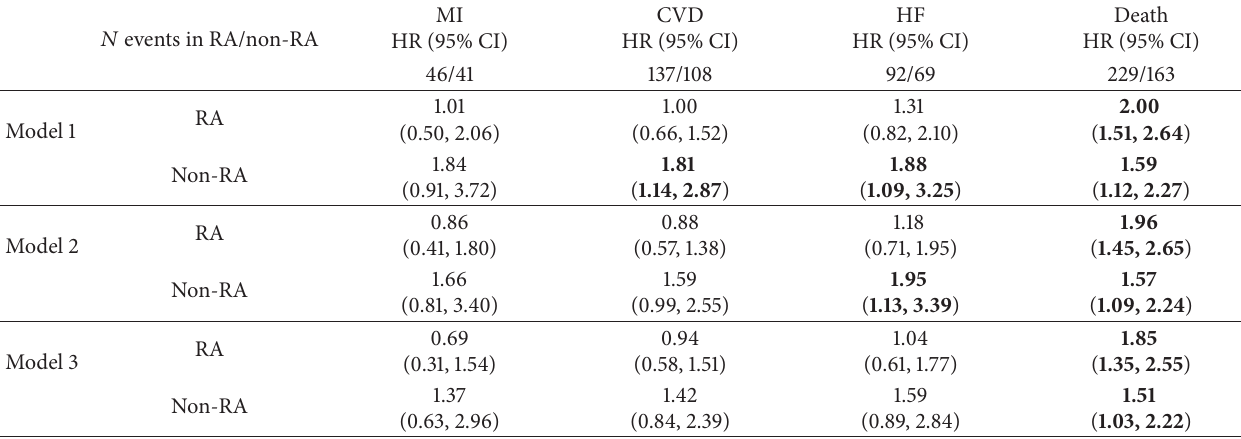
Table 3: Associations between hyperuricemia and cardiovascular disease/mortality in patients with rheumatoid arthritis (RA) and subjects without RA (non-RA).